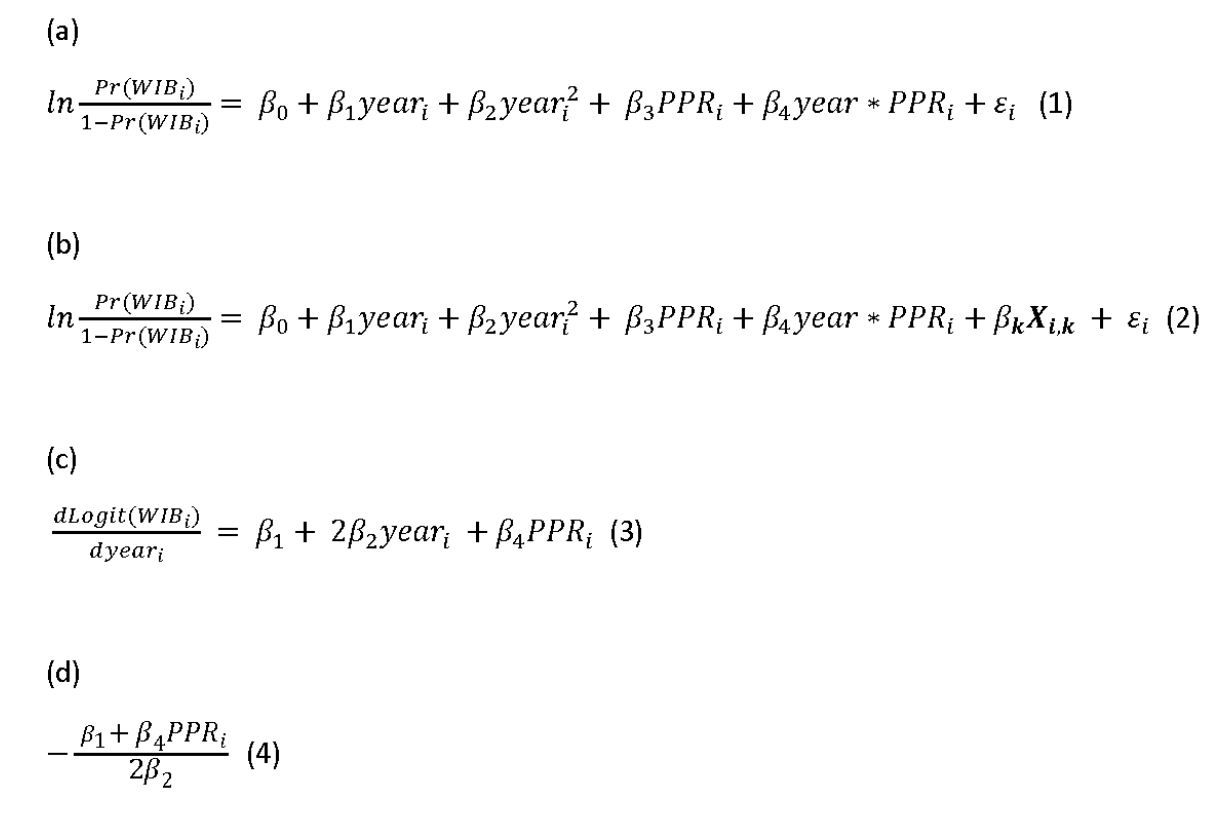
Figure 1. Equations for logistic regression models, slope, and change of point for time